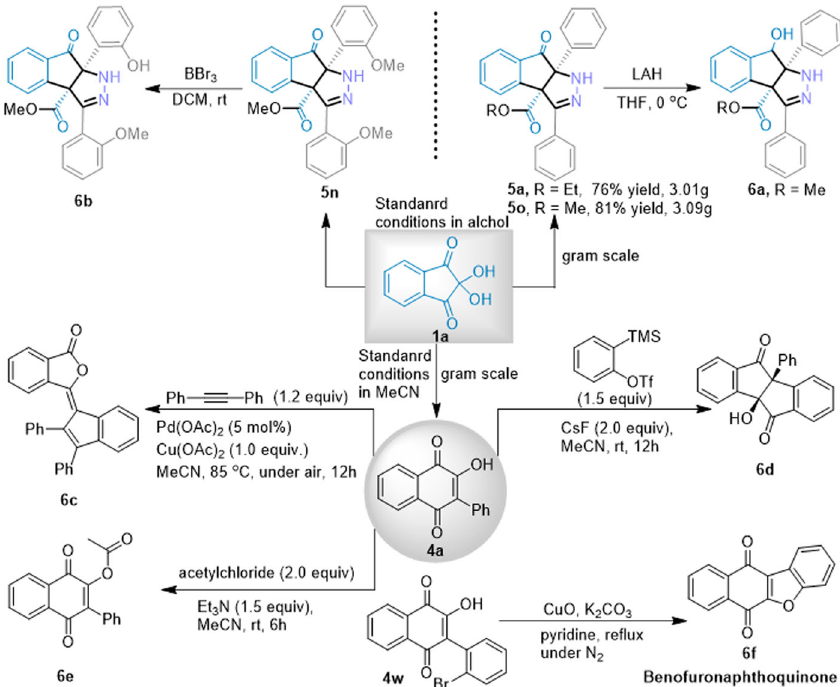
Fig. 9 Synthetic application. Multigram-scale experiments and synthetic versatility of lawsones and indenopyrazolones. General conditions: see SI, Supplementary Method